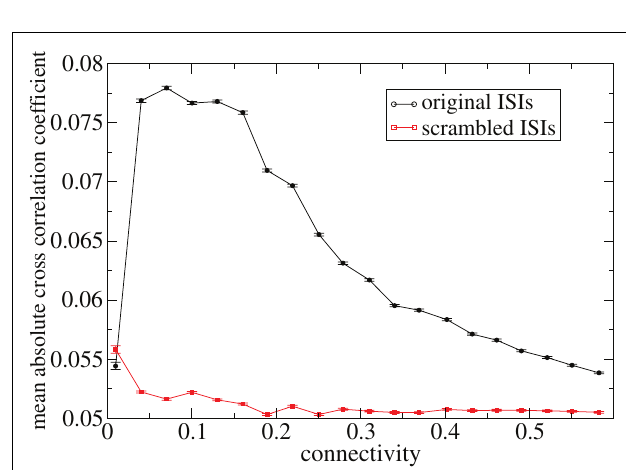
FIGURE 4 |Variation with connectivity of mean absolute firing rate cross-correlation across all cell pairs in 500 cell network simulations based on a 200-ms window corresponding to Figure 1. Black – original ISIs, red – scrambled